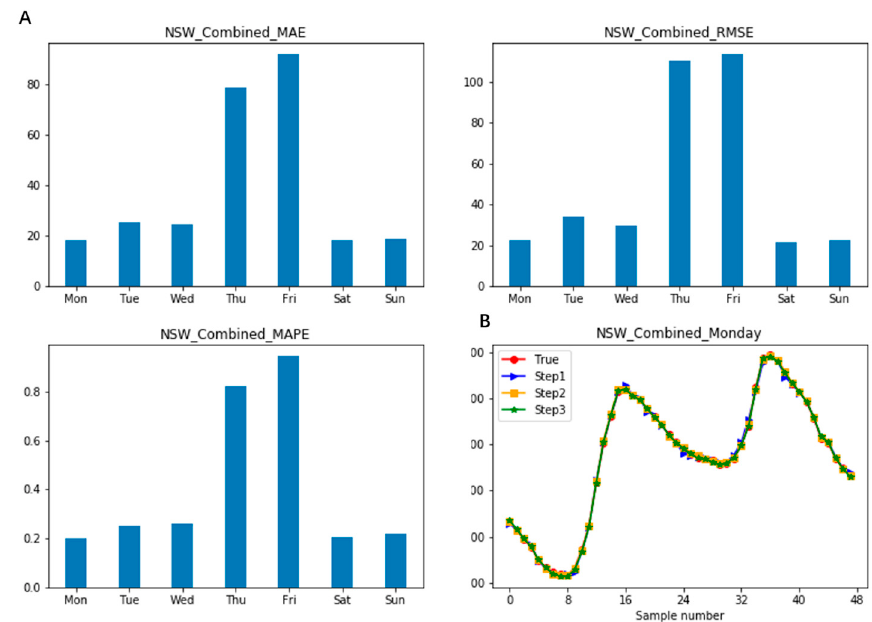
Figure 6. Comparison of the 1-step, 2-step, and 3-step forecasting results of the combined model on Monday. ( A ): three evaluation metrics results of Combined model. ( B ): Combined model forecasting results on